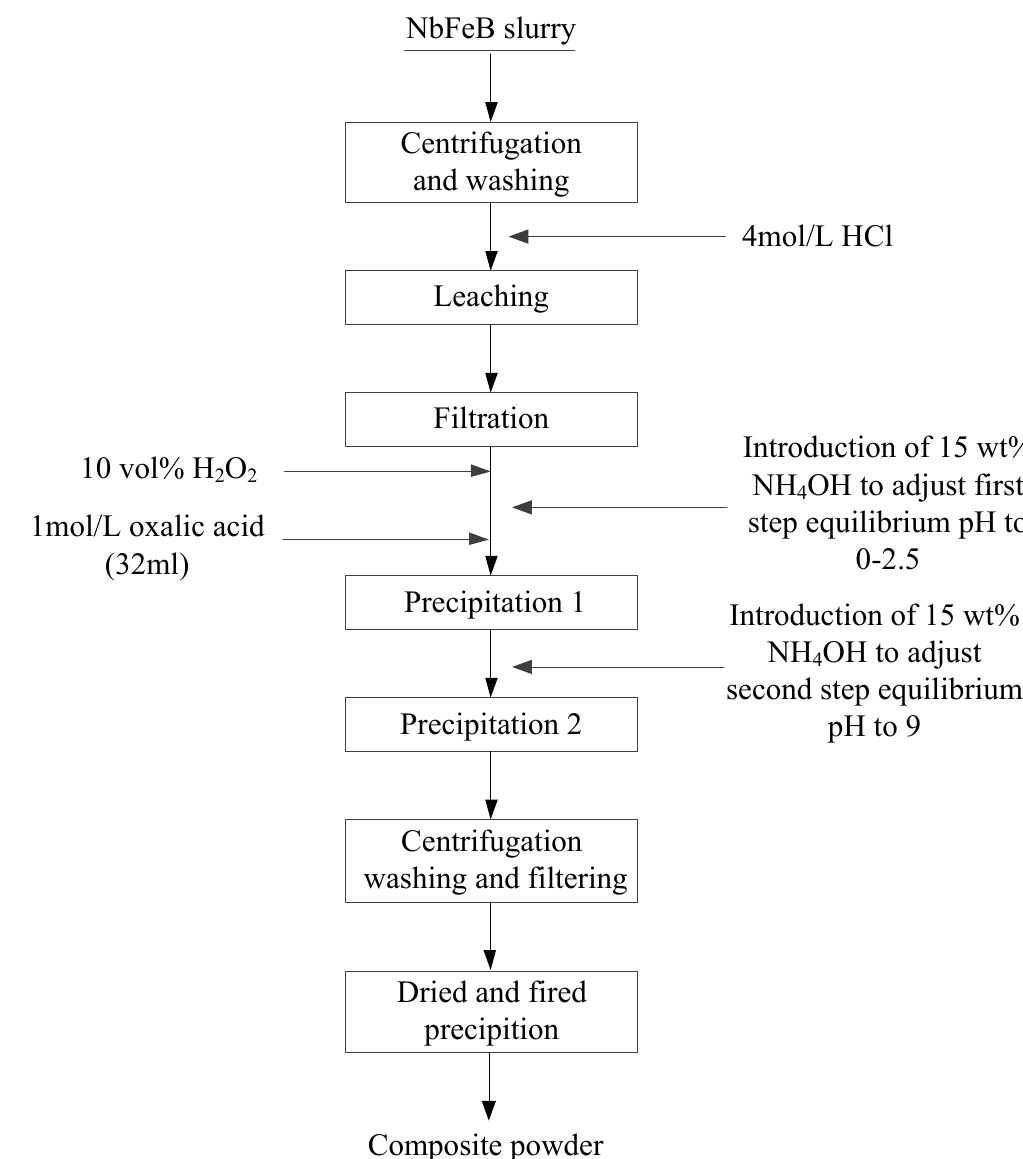
Figure 15. Scheme for the synthesis of a composite powder from NdFeB magnet scrap leaching solution using a co-precipitation method [37]; published by Elsevier, 2014.